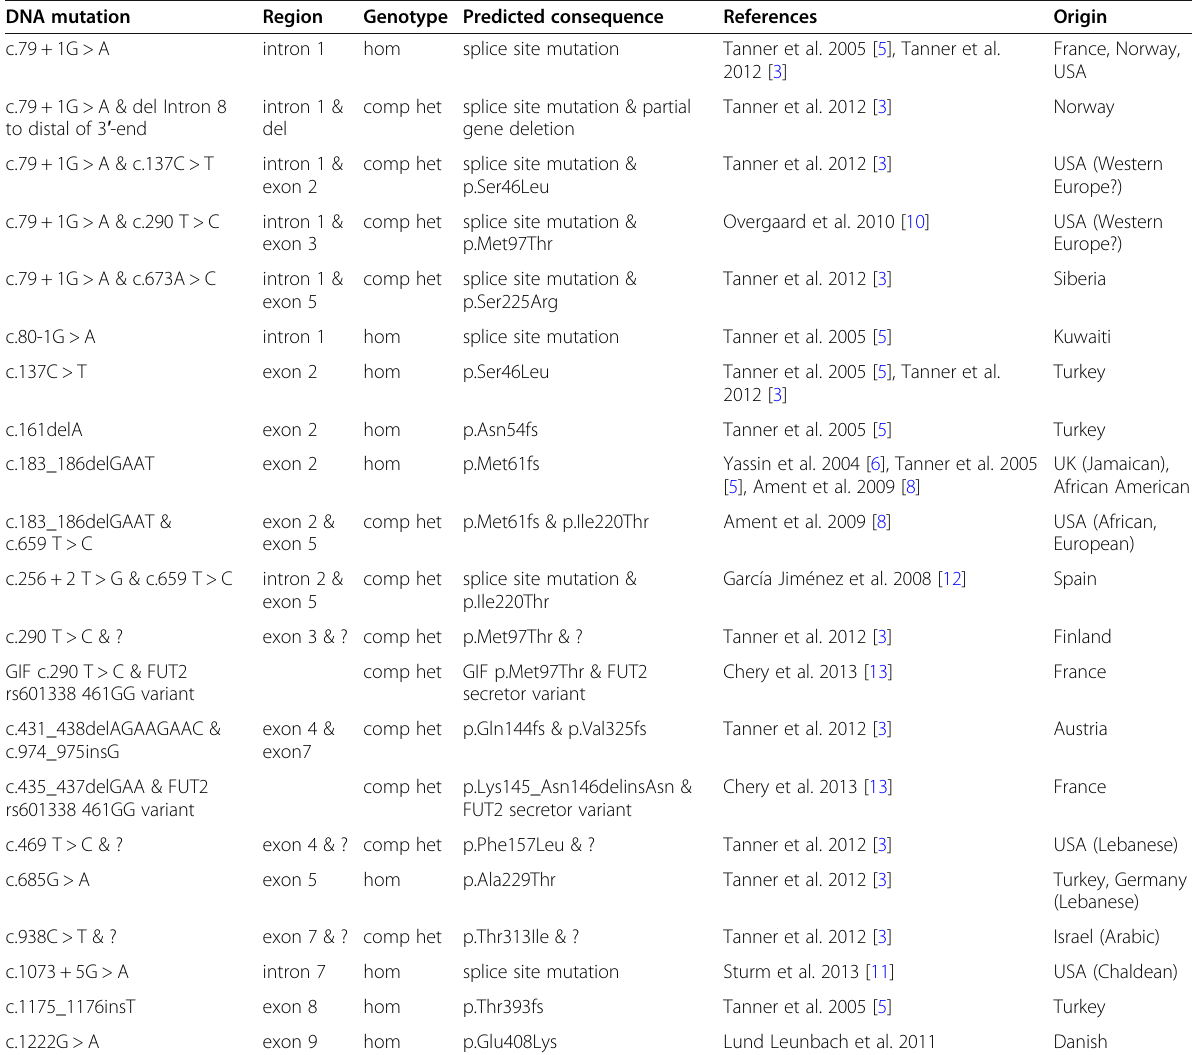
Table1 Summary mutations in the GIF gene according to previous literature (add to page 5 line 19) DNA